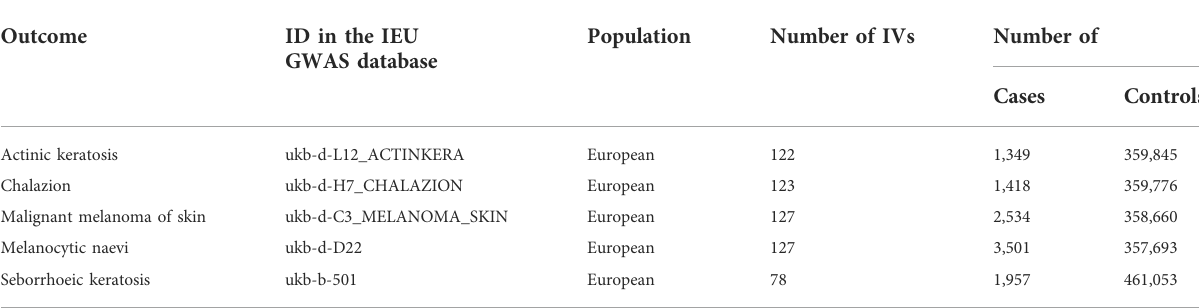
TABLE 4 Summary of the outcome GWAS in the replication study.